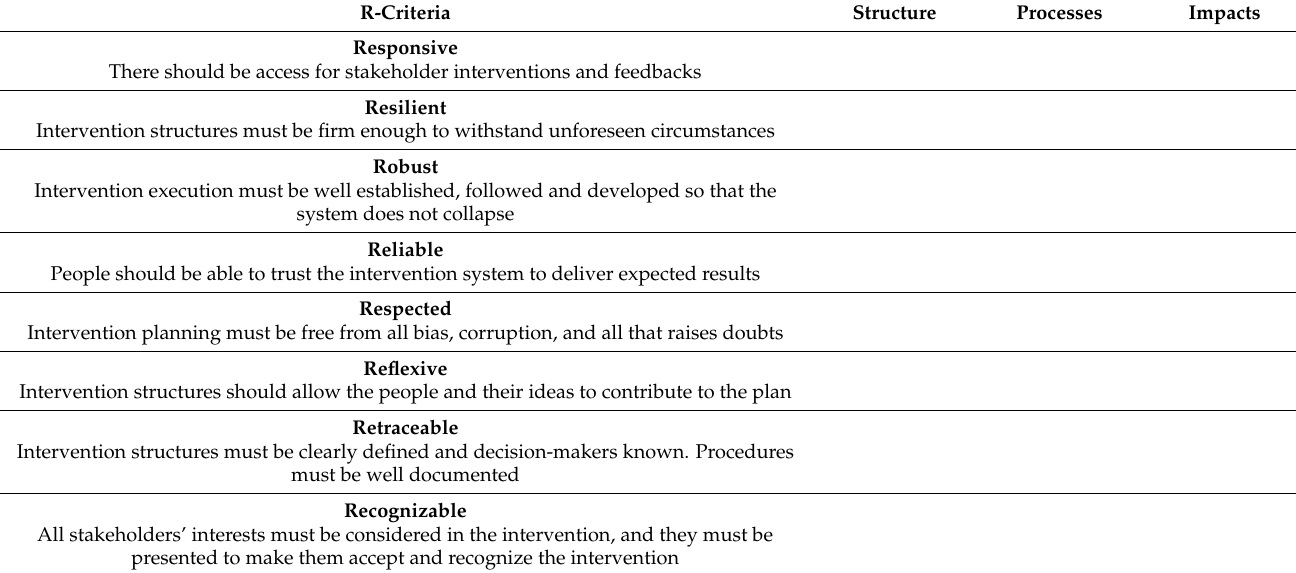
Table 2. 8R-evaluation matrix (de Vries